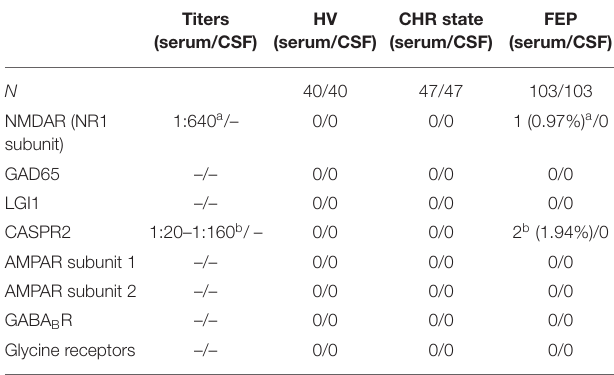
TABLE 3 | Prevalence of neural autoantibodies in serum and CSF of individuals with CHR states or schizophrenia and healthy controls. Titers